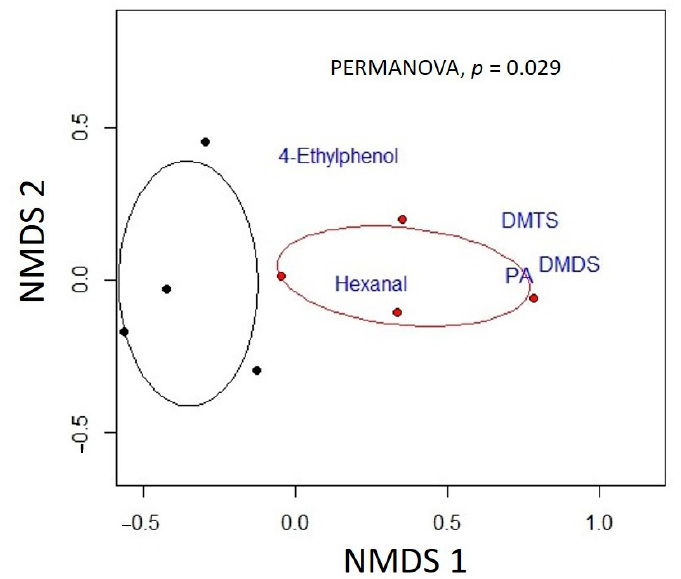
Figure 4. Nonmetric dimensional scaling plot describing differences in volatile organic compound profiles of fresh (black points) and old (red points) mouse carcasses used as brooding resources for N. vespilloides mating pairs. Data points denote individual carcasses, and ellipses depict the standard error around the mean centroid for each carcass age. Blue text denotes placement of volatile organic compounds (VOCs) significantly associated with aged carcasses (according to indicator species analysis) in multivariate space. The placement of a particular VOC in multivariate space was calculated in the vegan package in R as the means of each of the carcass non-metric multidimensional scaling (NMDS) scores weighted by the square root of that VOC’s abundance.